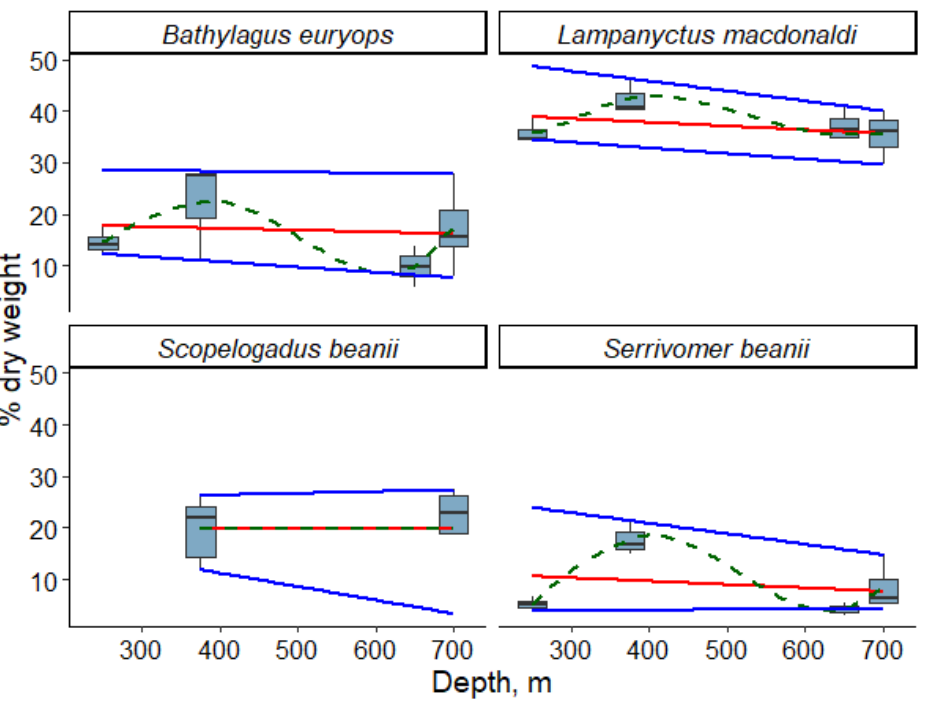
Figure 2. The change in total lipid content in muscles of mesopelagic fish species ( Bathylagus euryops , Lampanyctus macdonaldi , Scopelogadus beanii , Serrivomer beanii ) living at different depths in the Irminger Sea (North Atlantic). Note: red line—median linear regression, blue line—linear quantile regression (for the 10th and 90th percentiles), green line—smoothed regression.